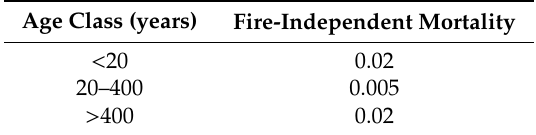
Table A2. Parameters for fire-independent mortality function MortalityI